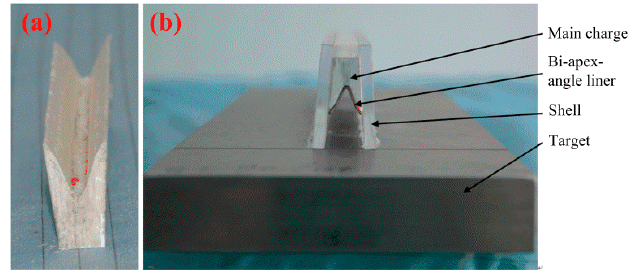
Figure 4. ( a ) Main charge; ( b ) BLSC and target.